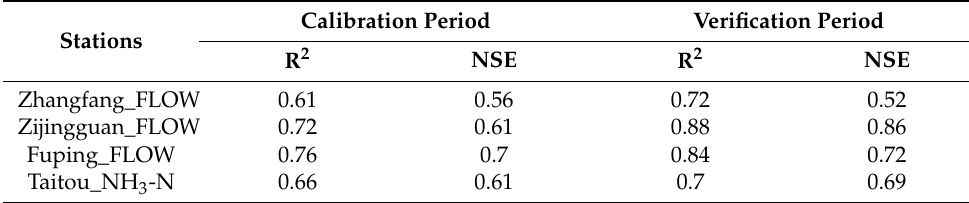
Table 2. Calibration and validation results of runoff and water quality in the model.